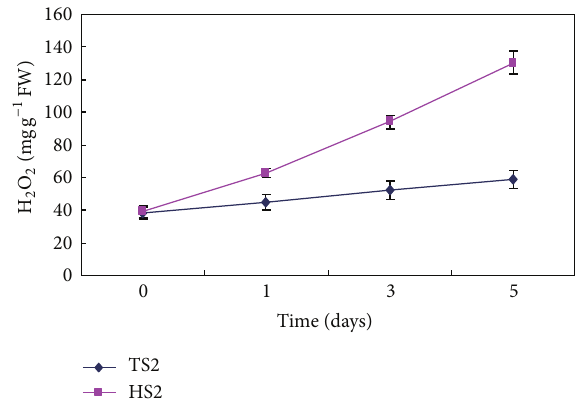
Figure 5: Comparison of H 2 O 2 content between HS2 and TS2 plantlets after transplantation in a simple shed covered with a 50% sunshade